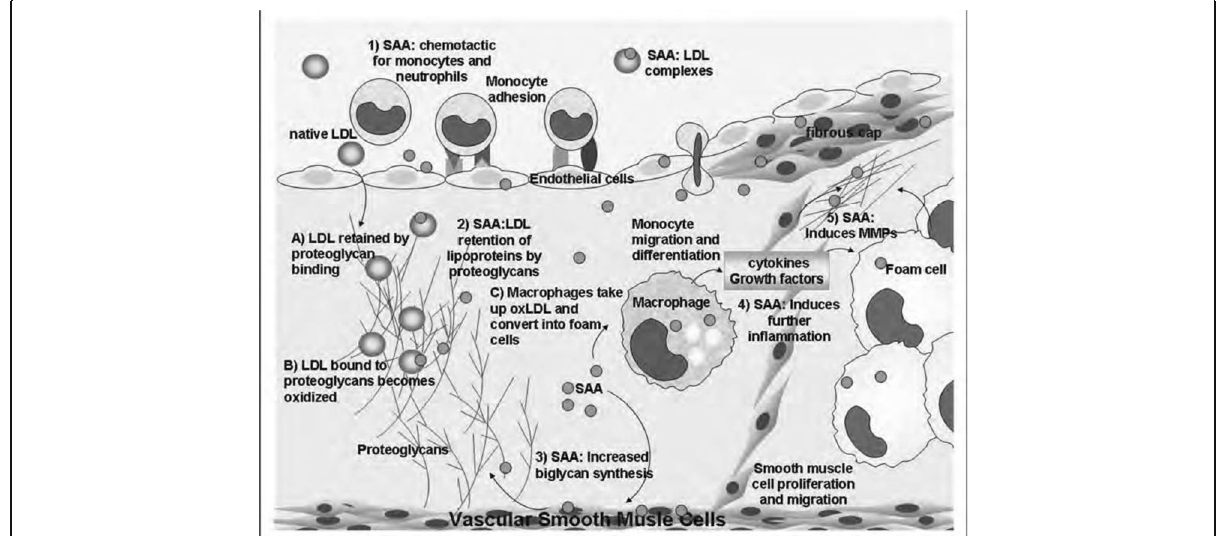
Fig. 8 Proposed sites for participation of SAA in atherosclerosis. (King et al. (2011), Copyright Lippincott Williams & Wilkins, 2011, used by